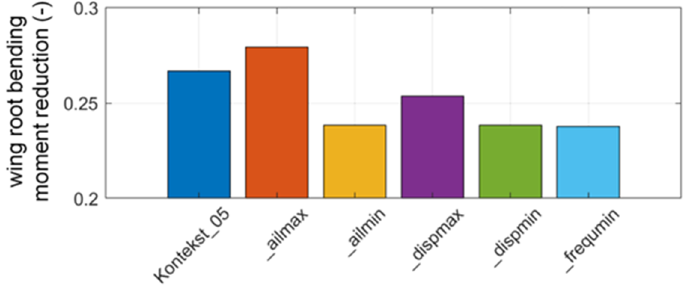
Figure 15. Comparison of the achieved wing root bending moment (WRBM) reduction at a true airspeed of 40 m/s evaluated in terms of the expected variance for a white noise gust excitation simulated by pitching the wing.